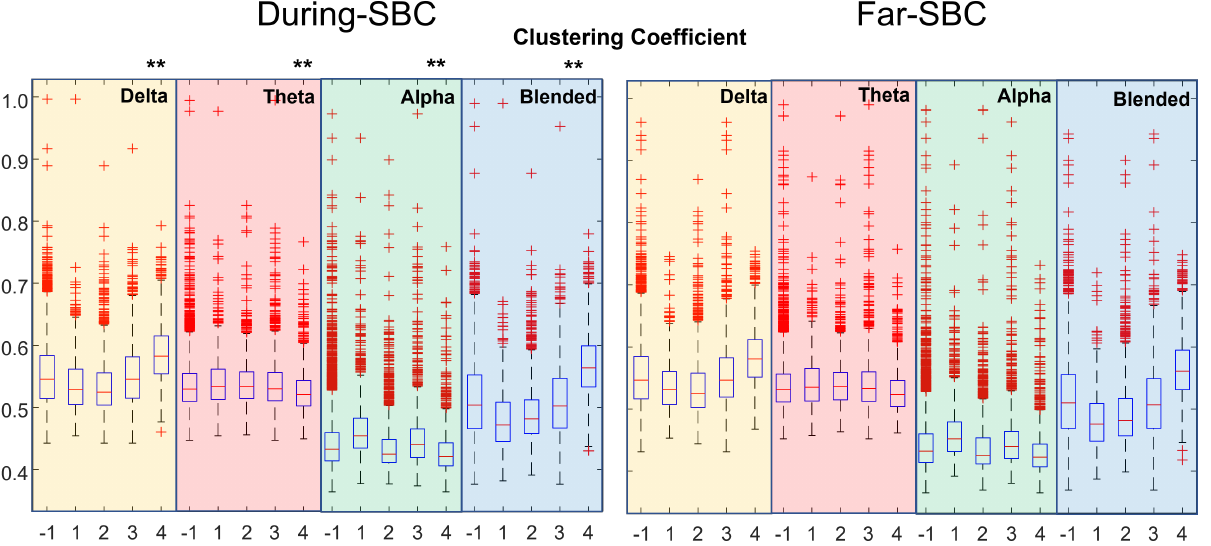
Figure 3. Distribution of clustering coefficient (same format as Figure